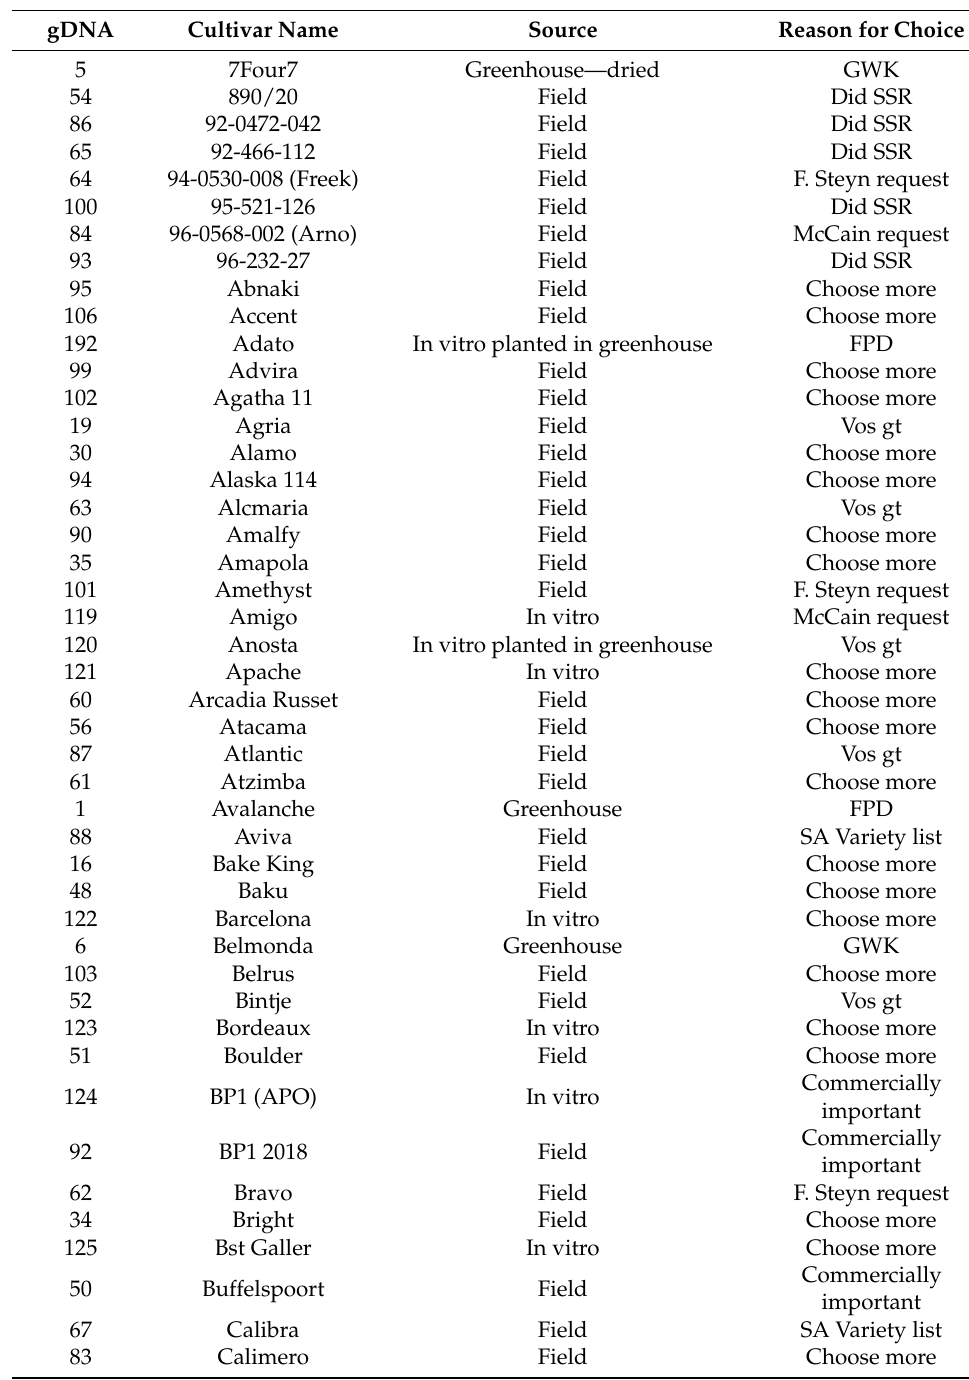
Table A1. Potato germplasm list selected for SeqSNP genotyping (190 cultivars). GWK, FPD and FL at the “Reason for choice” refers to contributions made by GWK Trading, First Potato Dynamics and Pepsico (FL lines) respectively. Vos gt indicate those overlapping with [11,27]. SA variety list indicate those on the South African potato variety list (Department of Agriculture, Land Reform and Rural Development